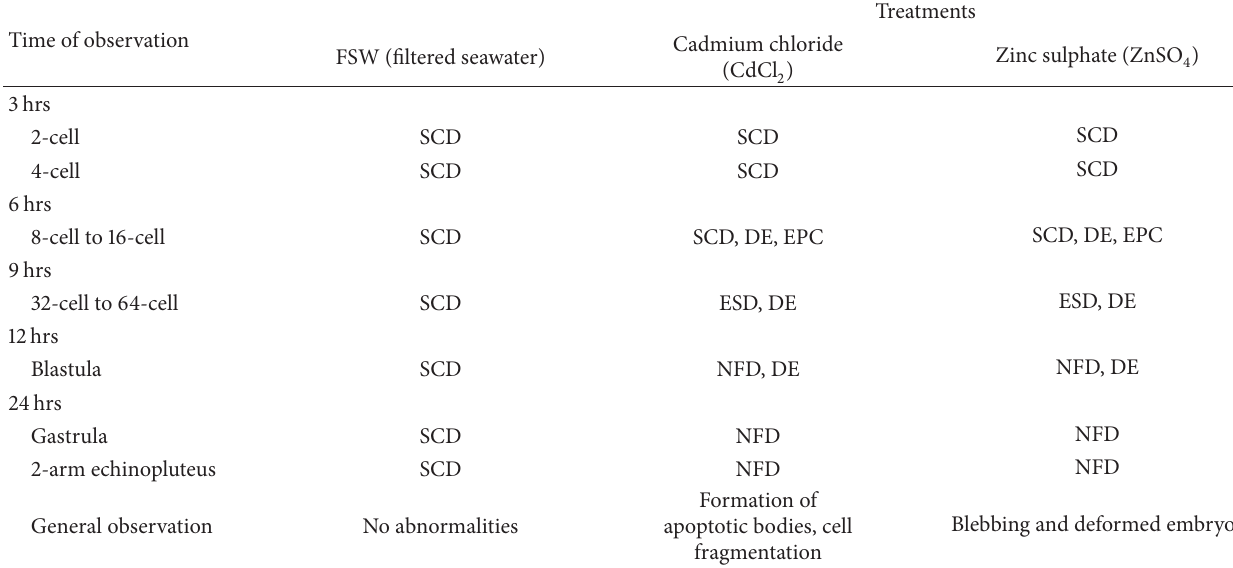
Table 2: The morphological observations on the embryos of T. gratilla treated with FSW, highest nongametotoxic concentration of CdCl 2 and ZnSO 4 during 3h, 6h, 9h, 12h, and 24h.